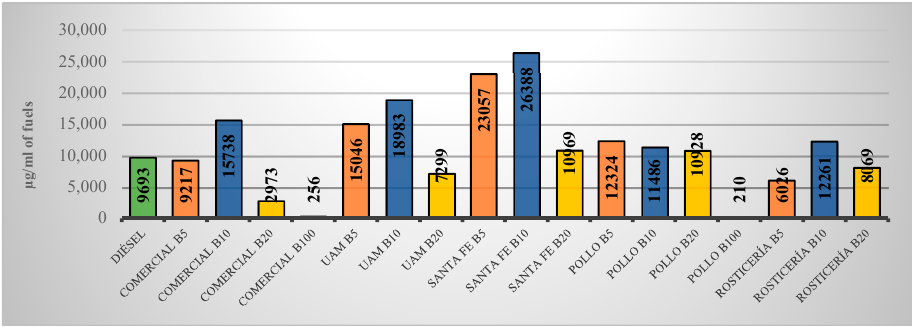
Figure 2. Concentrations of carcinogenic PAHs in the blends studied in µg mL − 1 of